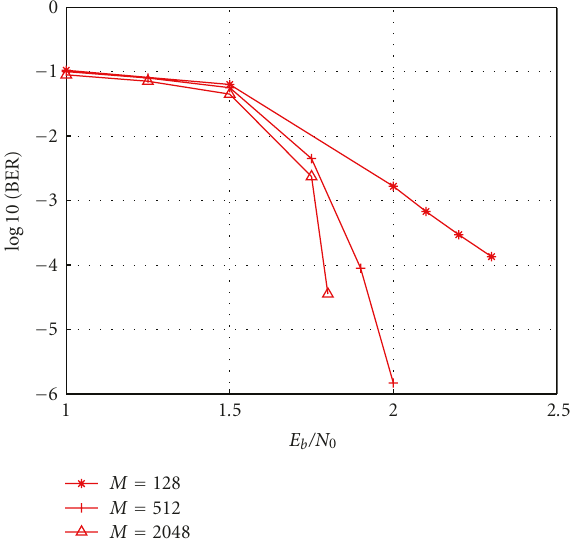
Figure 4: LDPC-CC decoder performance over the AWGN channel, based on codes and algorithms from